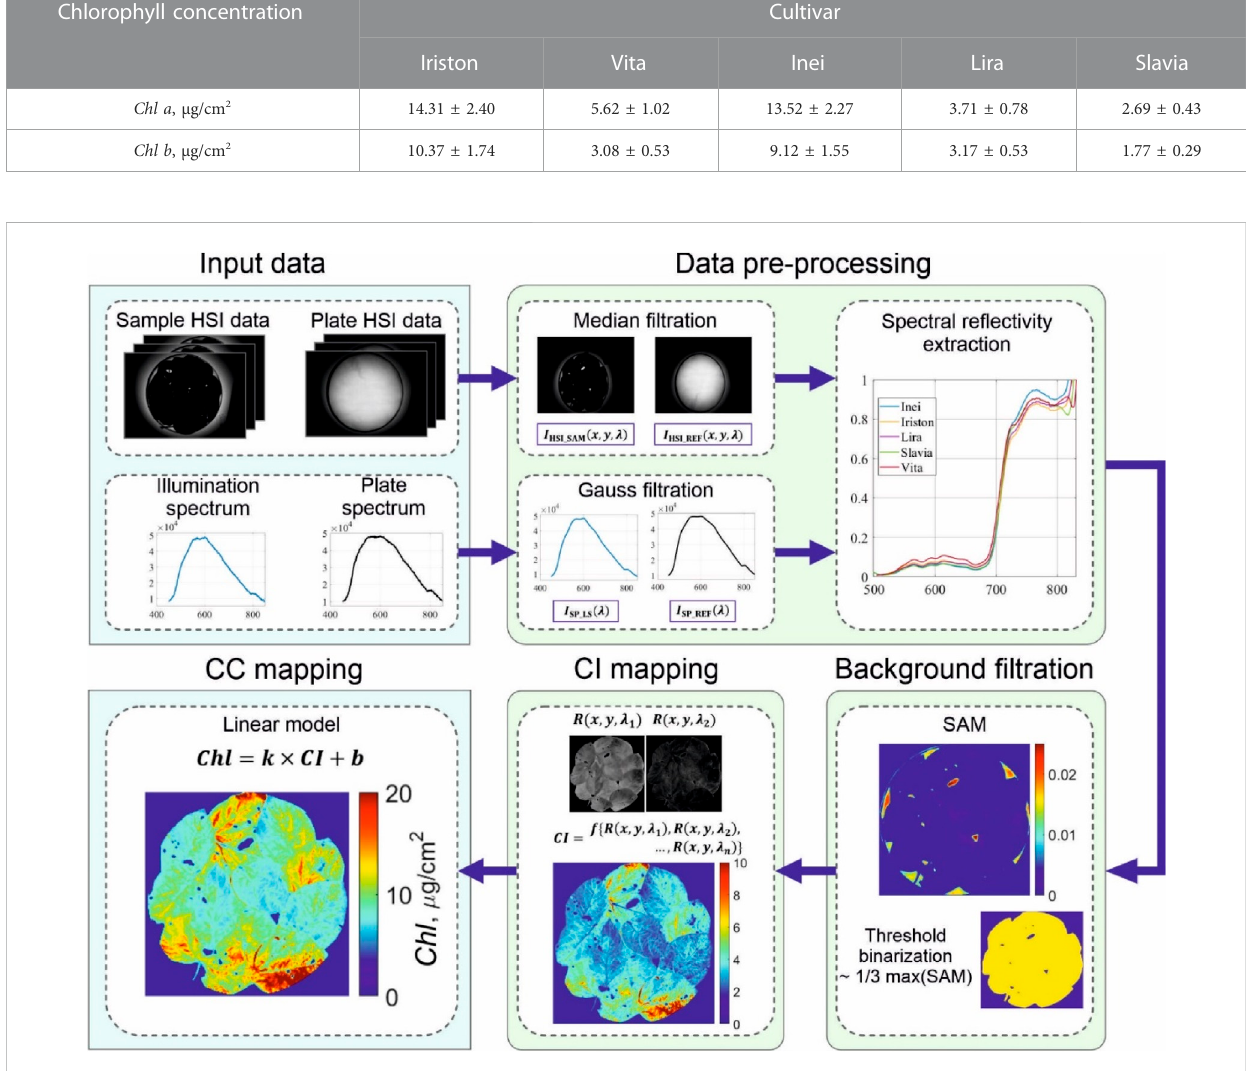
FIGURE 4 Data processing pipeline implemented for chlorophyll concentration mapping. It requires light source illumination and plate re fl ectance spectra as wellasspectralimagesofthesampleandanempty plate.Joint processingofthesedata allowsaccuratemeasuringthespectralre fl ectivity R ( x , y , λ )ofthe sample and background removal. After R ( x , y , λ ) is obtained, any CI may be evaluated and then converted to chlorophyll concentration S hl via linear